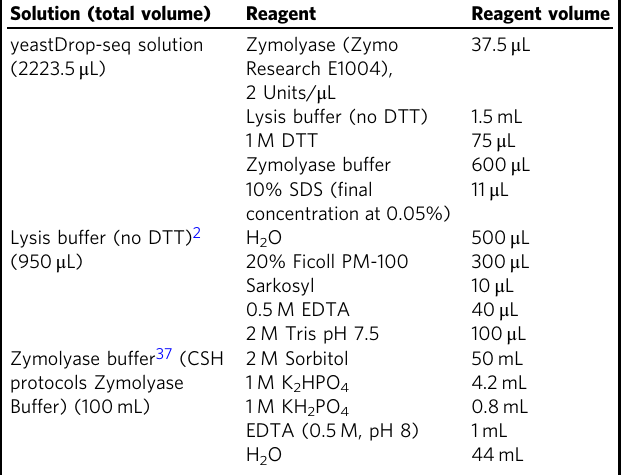
Table 1 yeastDrop-Seq